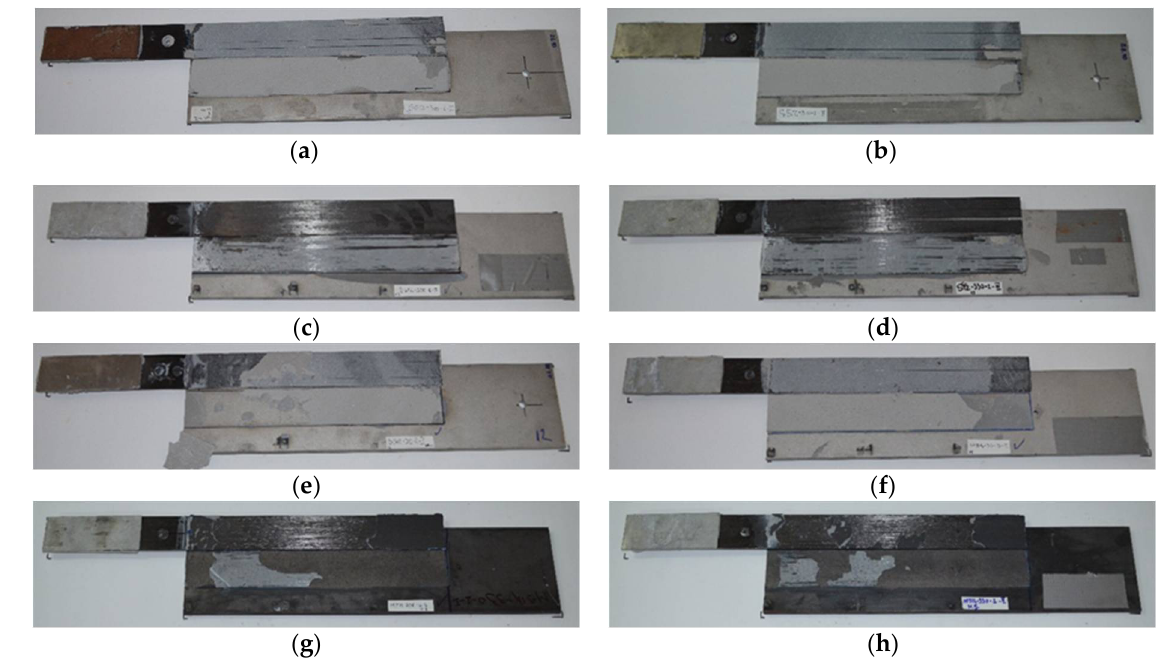
Figure 6. ( a ), ( b ) Specimens 1 and 2, Failure mechanism: Cohesive adhesive layer failure (dominant) and CFRP strip delamination (secondary); ( c ), ( d ) Specimens 8 and 10, Failure mechanism: CFRP–adhesive interface debonding; ( e ), ( f ) Specimens 6 and 27, Failure mechanism: Cohesive adhesive layer failure (dominant), CFRP strip delamination (secondary) and steel–adhesive interface debonding (tertiary); ( g ), ( h ) Specimens 33 and 34, Failure mechanism: steel–adhesive interface debonding (dominant) and CFRP–adhesive interface debonding (secondary).